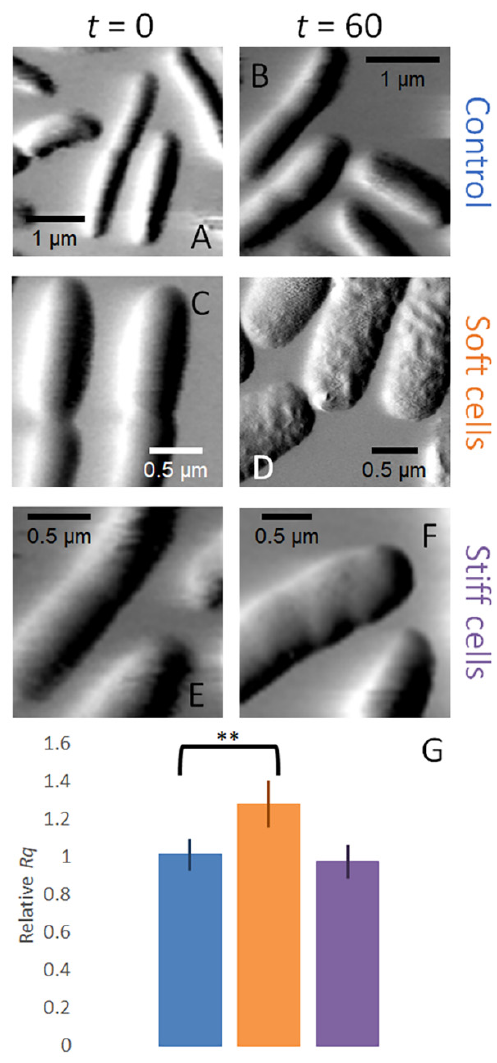
Figure 3. Amplitude images of E. coli biofilm cells captured by AFM. ( A ) Cells in an untreated biofilm at t = 0 min. ( B ) Cells in an untreated biofilm at t = 60 min. ( C ) Soft cells in a treated biofilm at t = 0 min. ( D ) Soft cells in a treated biofilm at t = 60 min. ( E ) Stiff cells in a treated biofilm at t = 0 min. ( F ) Stiff cells in a treated biofilm at t = 60 min. ( G ) The relative Rq for untreated cells (blue), affected soft cells (orange), and unaffected stiff cells (purple). The error bars represent standard deviation and the affected cells have a significantly higher Rq than the untreated cells ( p ≤ 0.005). The data presented here are from different experiments, but are representative of the cells imaged (untreated n = 23, treated n = 57). ** p ≤